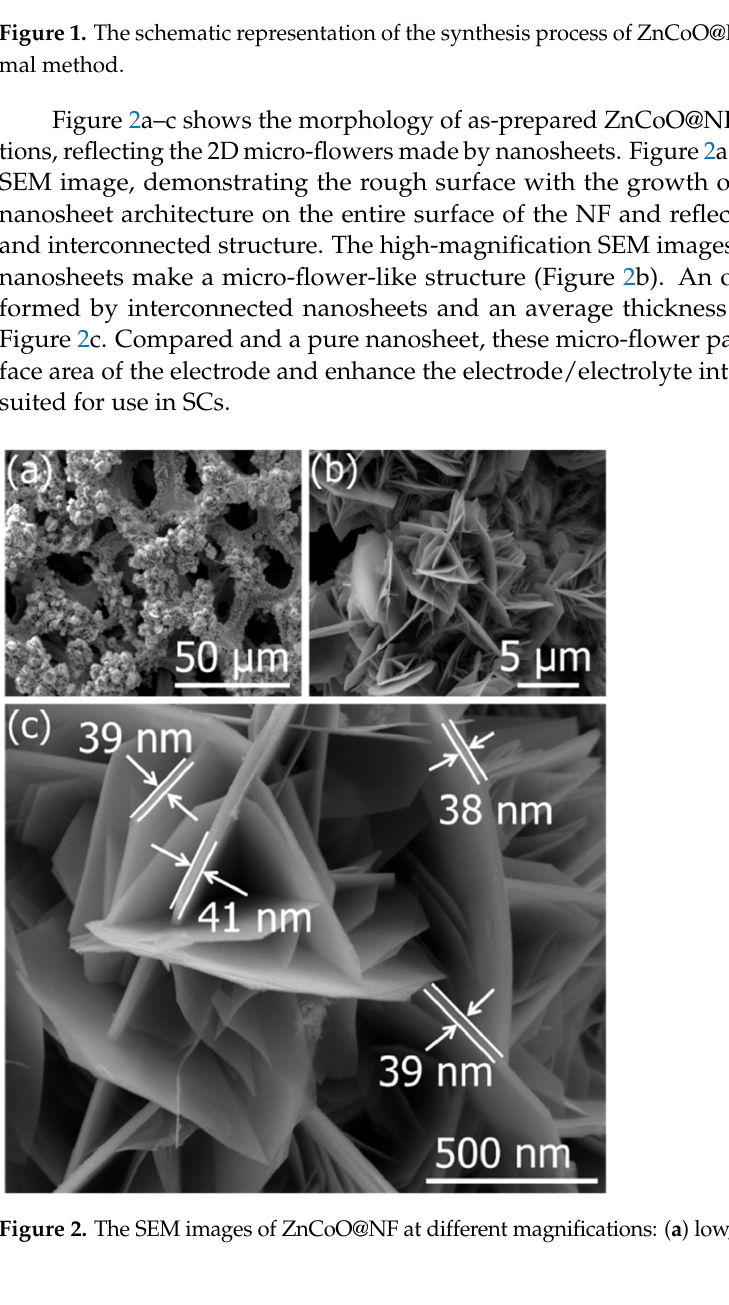
Figure 3. Typical ( a ) low-resolution and ( b ) high-resolution TEM images of the ZnCoO@NF nanosheets.